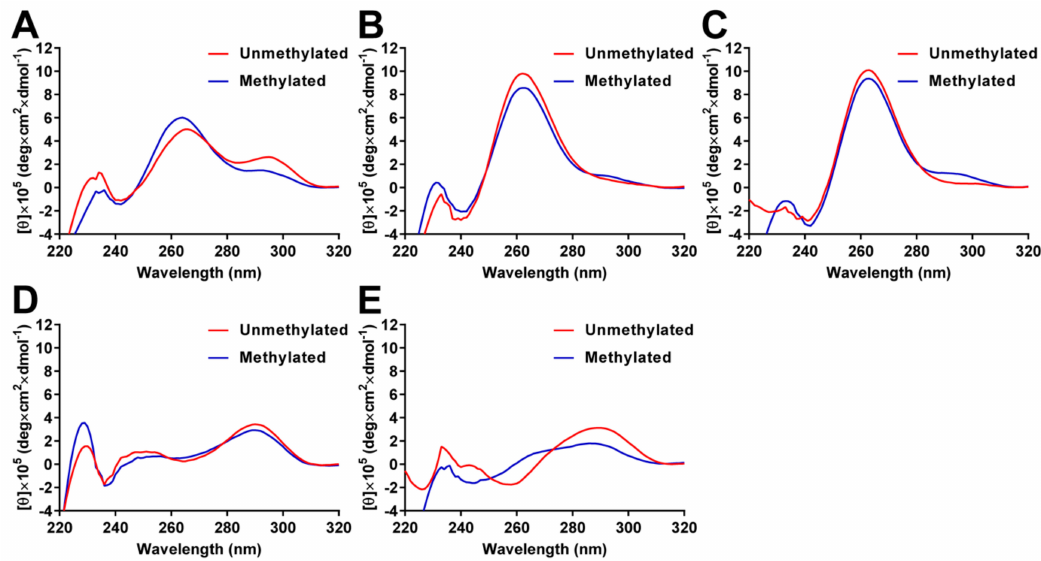
Figure 5. CD spectra of the unmethylated and methylated BCL-2 ( A ); VEGF ( B ); HRAS2 ( C ); c-KIT ( D ); and HRAS1 G4 DNAs ( E ) in the presence of the GST-SP1 in 10 mM Tris-HCl, 100 mM KCl, pH 7.4 at 25 ◦